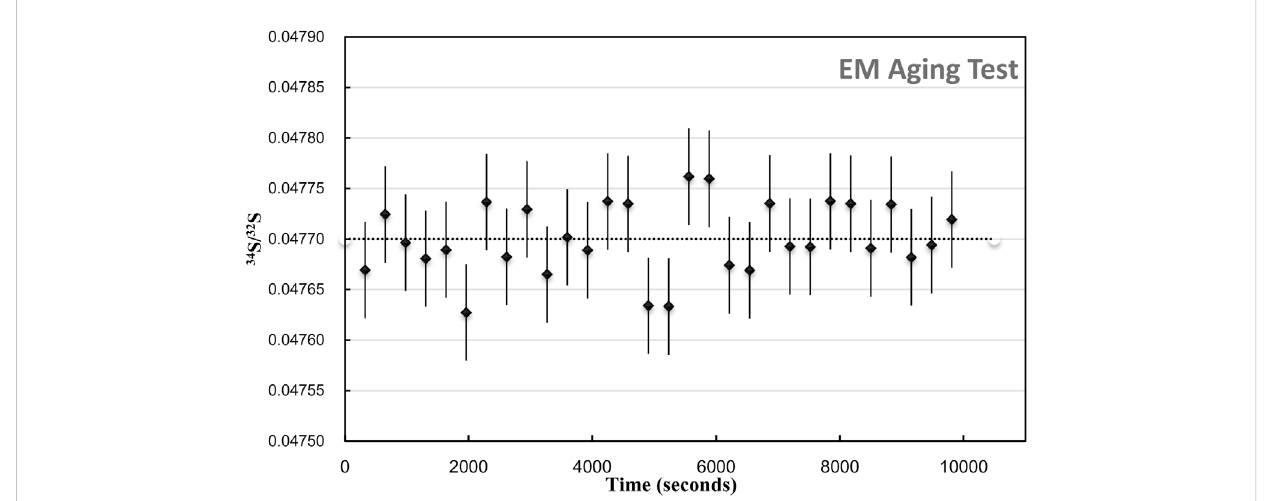
FIGURE 2 EM aging test. The plot of 34 S/ 32 S of 30 Frame within 9,900 s duration. The err bar is 1SE.